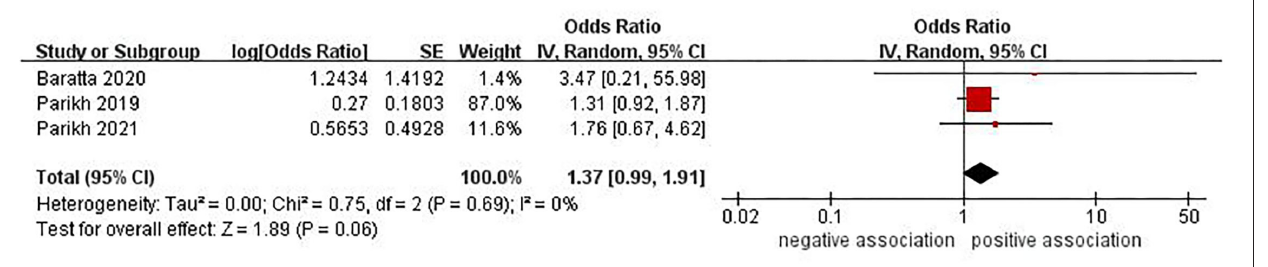
FIGURE 3 | Forest plot of evaluating the association between NAFLD-fibrosis (by NFS) and